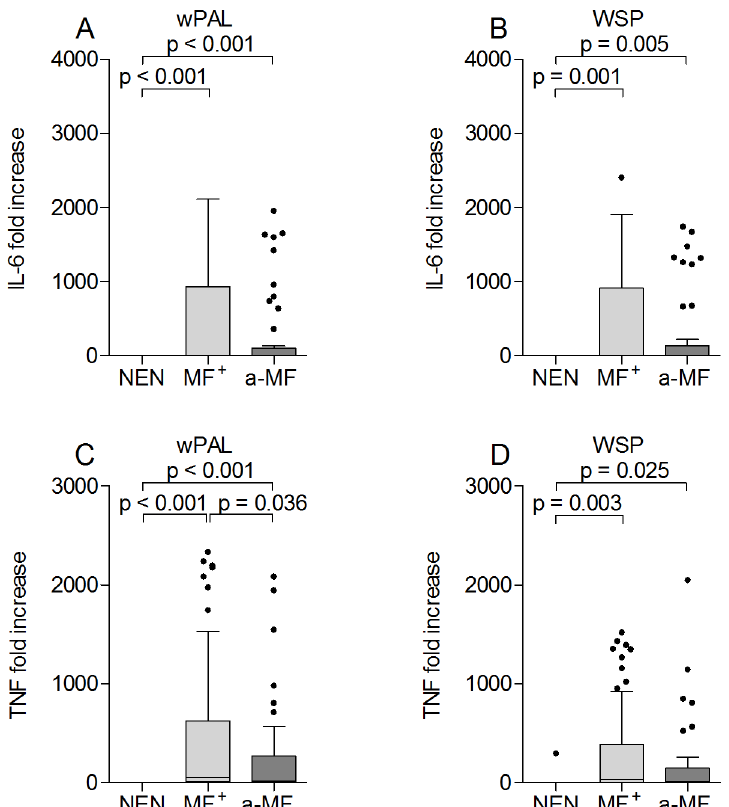
Figure 7. Induction of innate cytokines by Wolbachia -derived antigens. Isolated PBMCs (2 6 10 5 /well) from NEN or filarial infected MF + or a- MF patients were stimulated with either wPAL (5 m g/ml) (A and C) or WSP (5 m g/ml) (B and D), for 72 hours. Thereafter, levels of IL-6 (A and B) and TNF (C and D) were measured in the culture supernatants via ELISA. Data are plotted as fold increase over unstimulated controls. Graphs show box whiskers with median, interquartile ranges and outliers. Statistical significances between the indicated groups were obtained after Kruskal-Wallis and